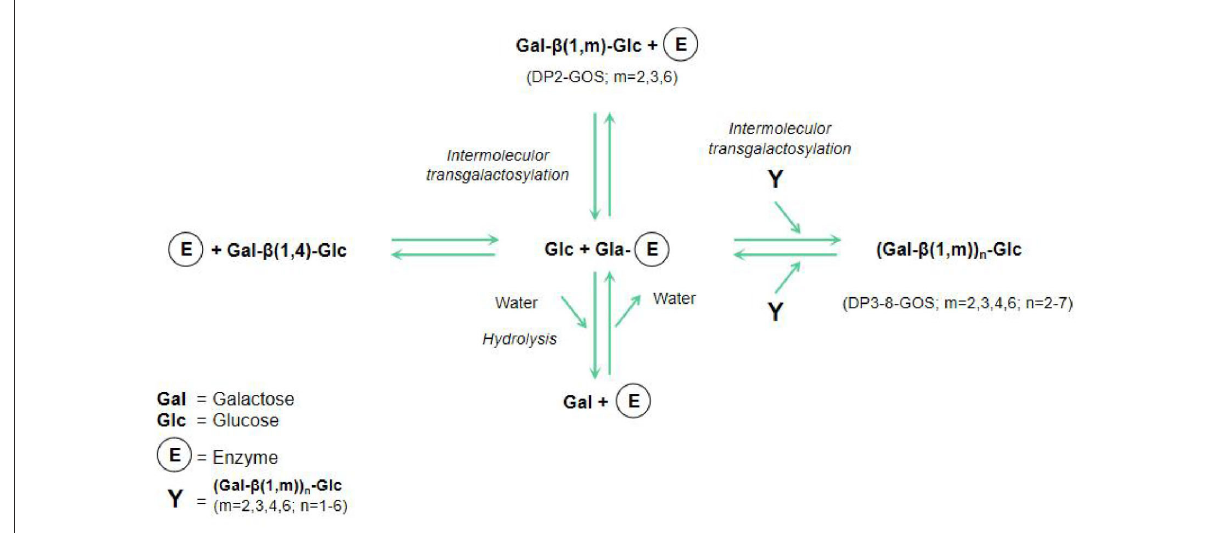
FIGURE1 Schematic model of lactose hydrolysis and GOS synthesis